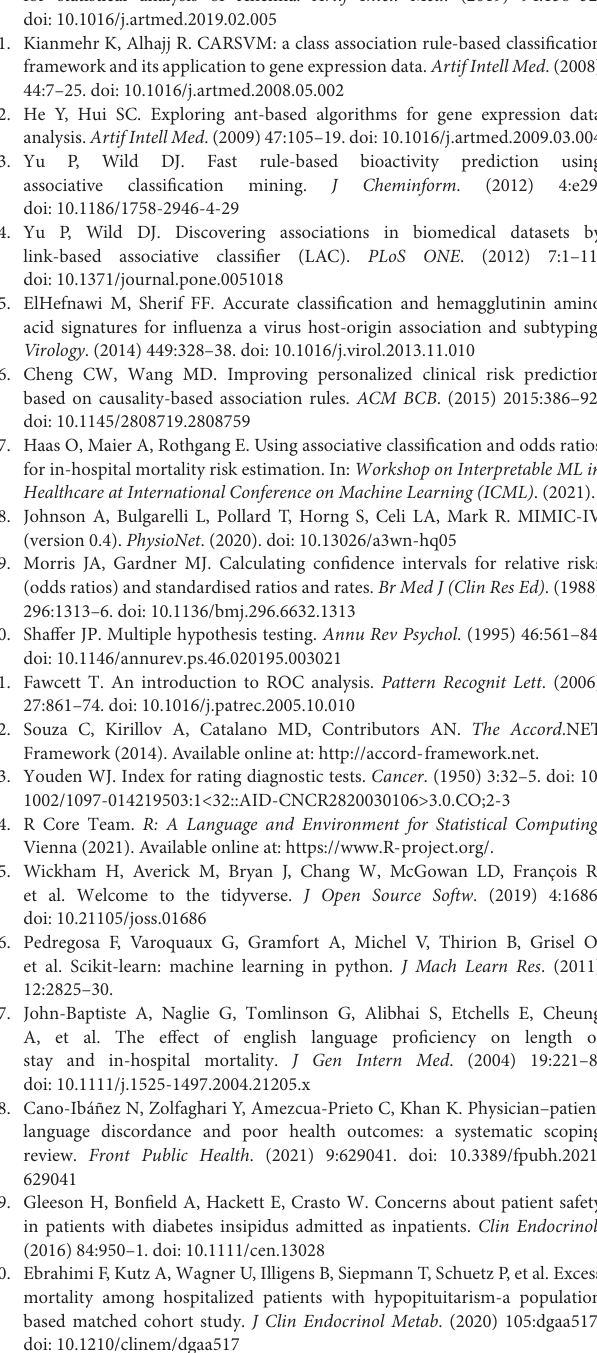
Supplementary Table 1 | The rules in the full model. Supplementary Table 2 | The rules in the minimal model. Supplementary Table 3 | One full Decision Tree